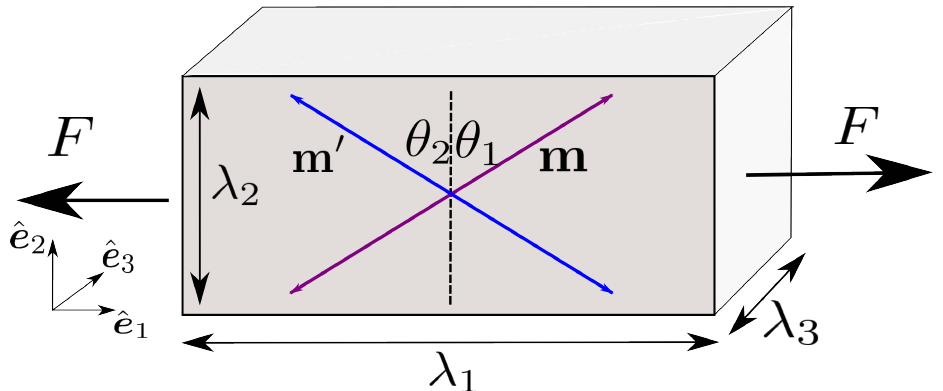
Figure 1. Uniaxial tension test of anisotropic two fibers family in spatial configuration. No symmetry is